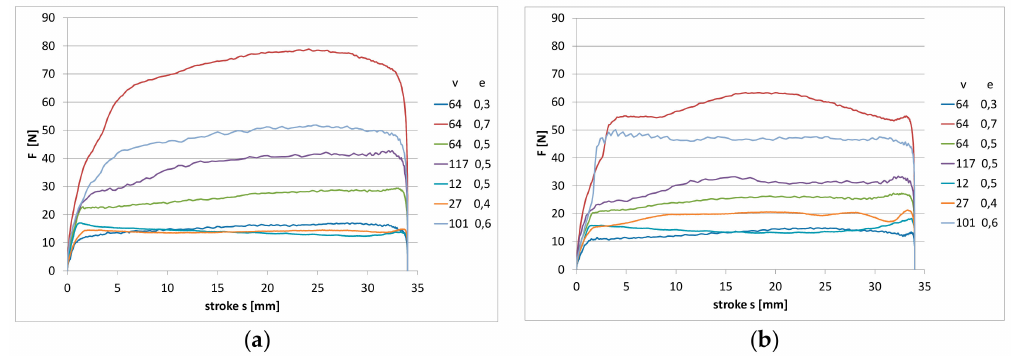
Figure 4. The measured values of friction force during one stroke of the rod: ( a ) fluoroelastomer (FKM) pure material; ( b ) FKM material with graphite